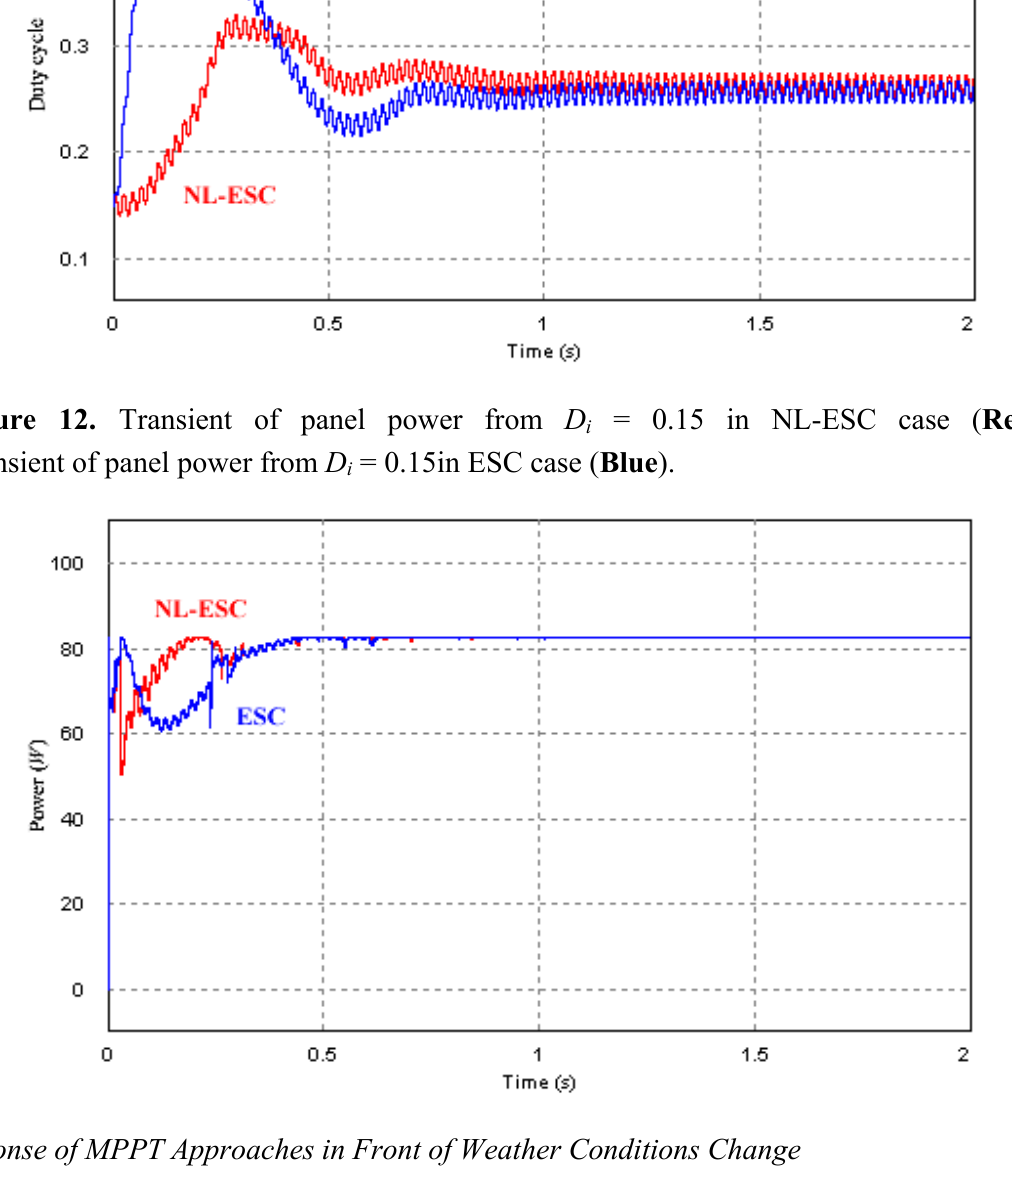
Figure 11. Transient of duty-cycle from D Transient of duty-cycle from D